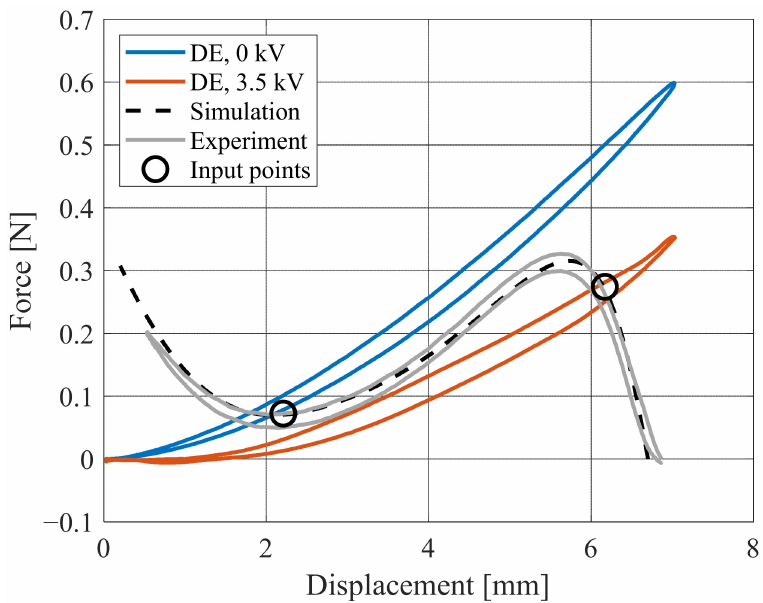
Figure 16. Design algorithm experimental validation. The input is represented by the desired intersection points (black circles), while the dashed black curve and solid gray curve represent the simulated and experimental results based on the optimized dome